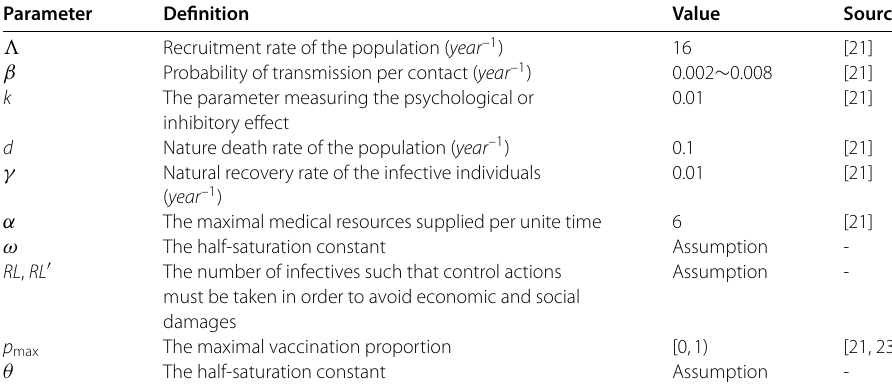
Table 1 Parameter definitions, values and source of model